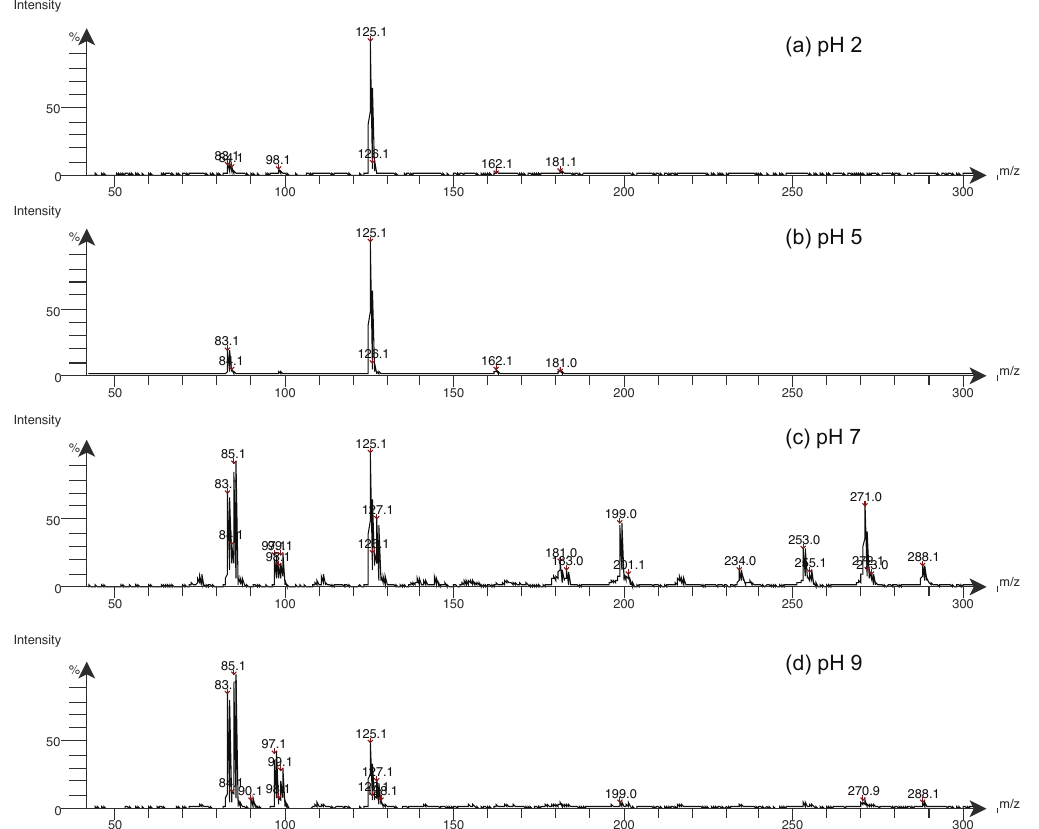
Figure 5. Atmospheric pressure chemical ionization (APCI) mass spectra for all four initial pH conditions in the reaction between 1.0M methylglyoxal and 1.0M ammonium sulfate, in capped samples, analyzed after 7 days. Intensity is set to 100% for the largest signal and does not correspond to concentration in the sample